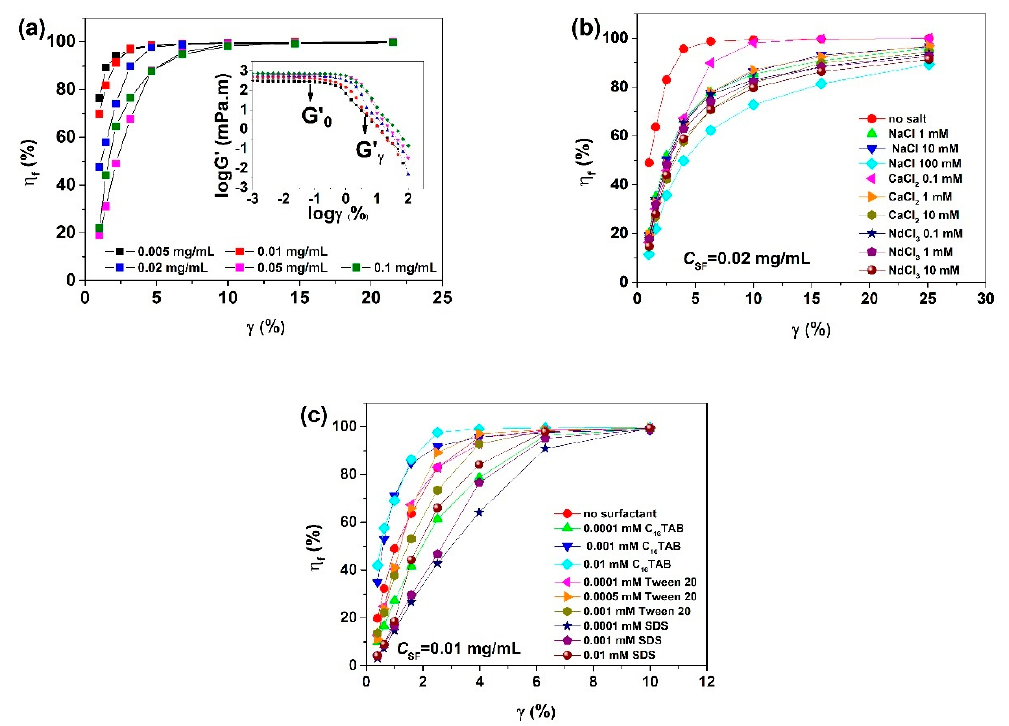
Figure 6. Change of the degree of structure fracture ( η f ) with strain ( γ ) for equilibrium adsorbed SF layers formed at the air/water interface under different solution conditions: ( a ) influences of C SF ; ( b ) influences of salts; ( c ) influences of surfactants. The inset in ( a ) is the double-logarithmic plot of the interfacial shear storage modulus ( G’ ) versus shear strain ( γ ) (taken from